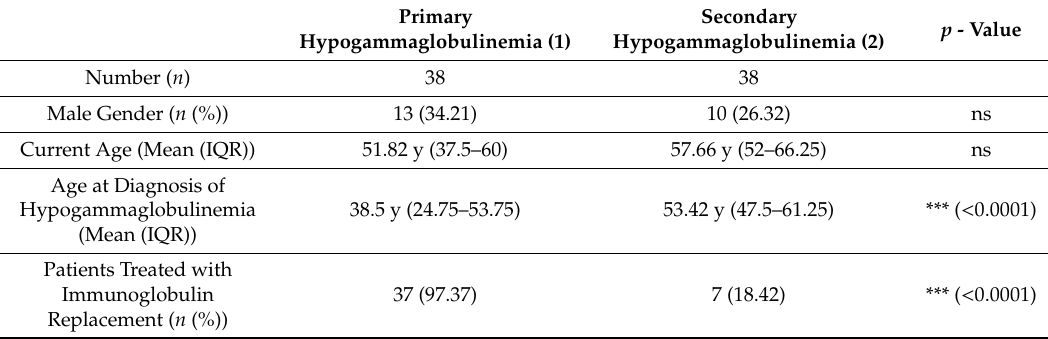
Table 1. Characteristics of studied patients with primary and secondary